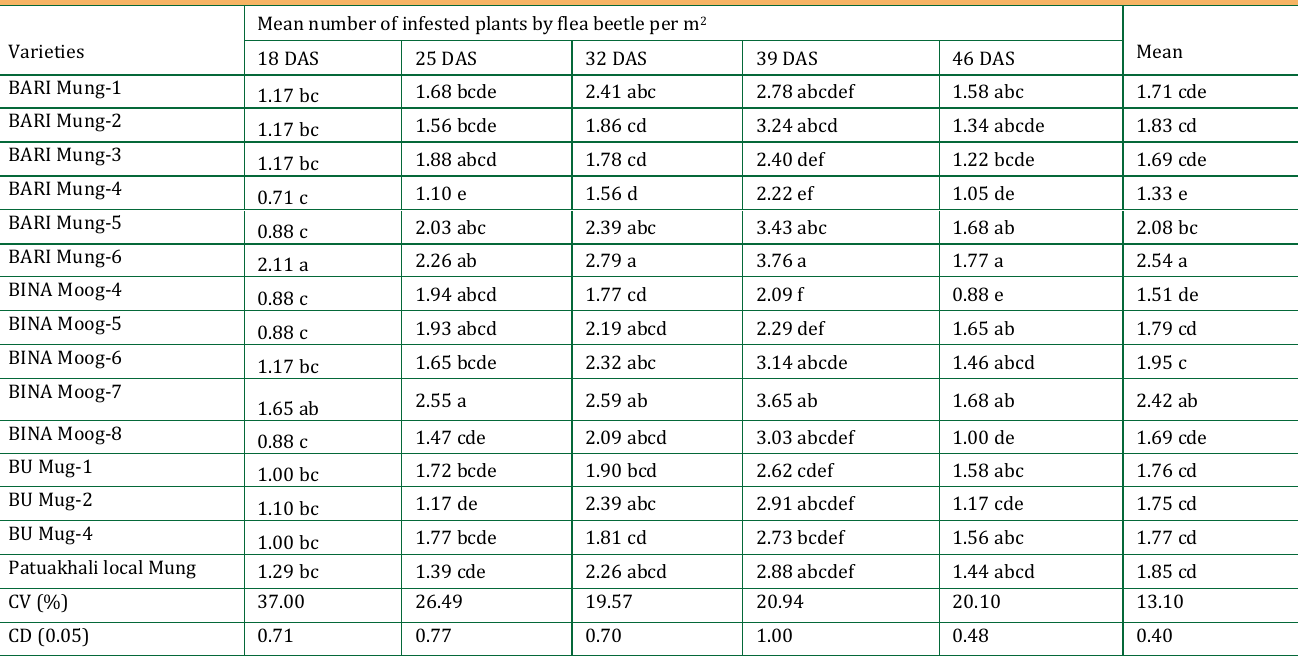
Table 2: Mean number of infested plants by flea beetle per m 2 on different mungbean varieties